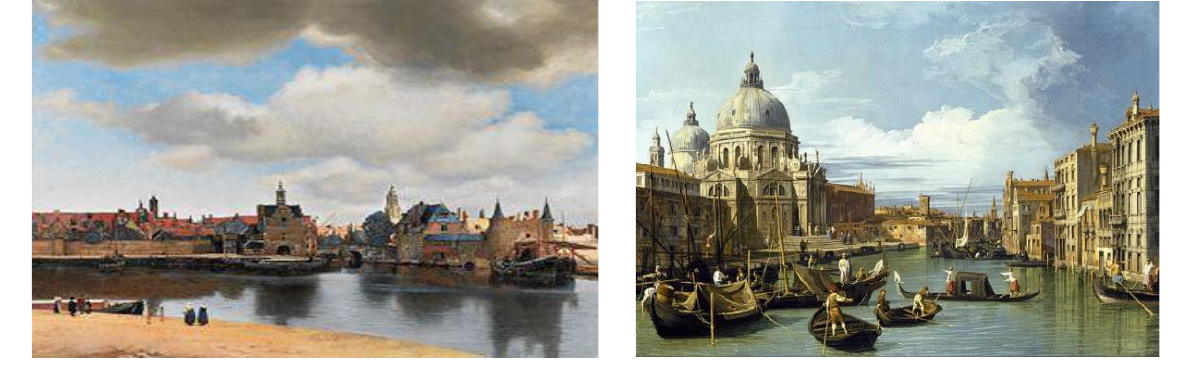
Fig. 6 'View of Delft' 1660-1661 Oil on canvas 96.5 cm × 115.7 Fig. 7 the Entrance to the Grand Canal, 1730 oil on canvas Painting cm 49.6 cm x 73.6 cm